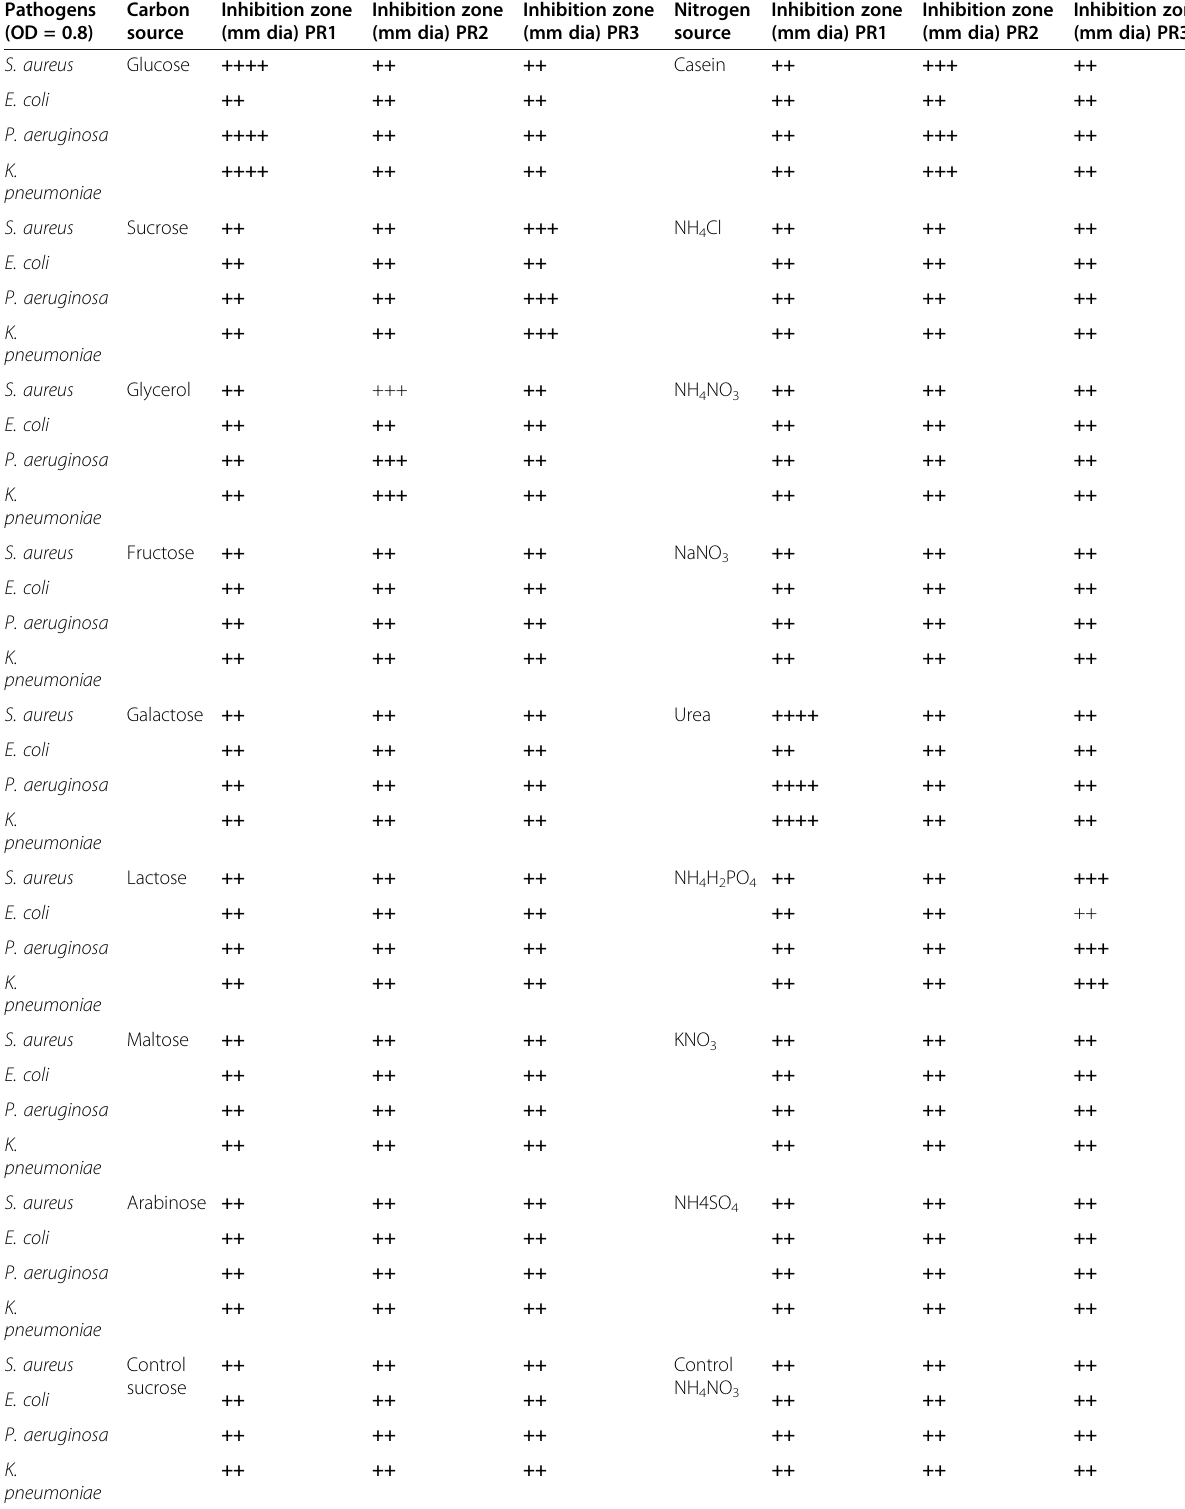
Table 5 Effect of carbon and nitrogen sources on antibacterial activity by PR1, PR2, and PR3 Pathogens (OD =